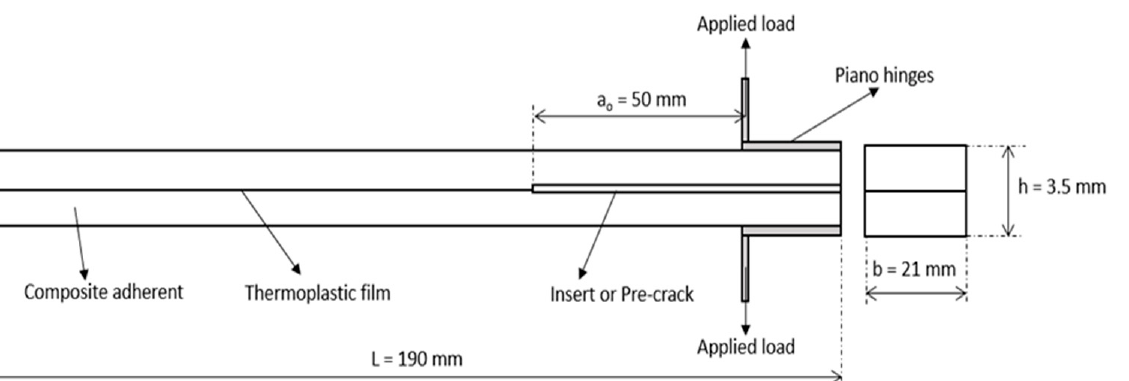
Figure 3. GFRP laminate manufacturing schematic.